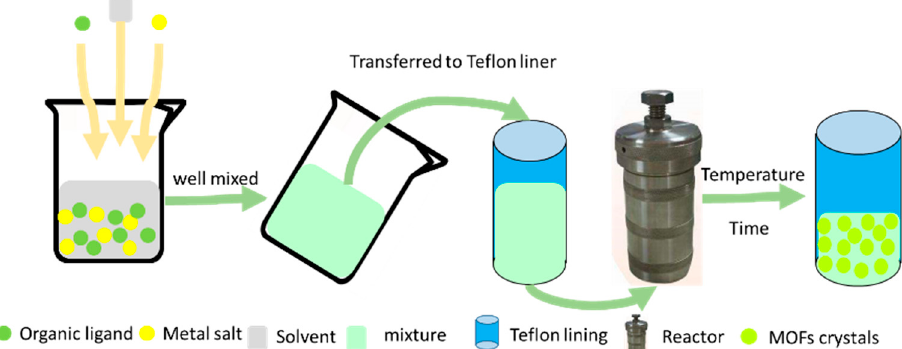
Figure 3. Schematic diagram for MOF synthesis by the hydrothermal method or the solvent heating method.